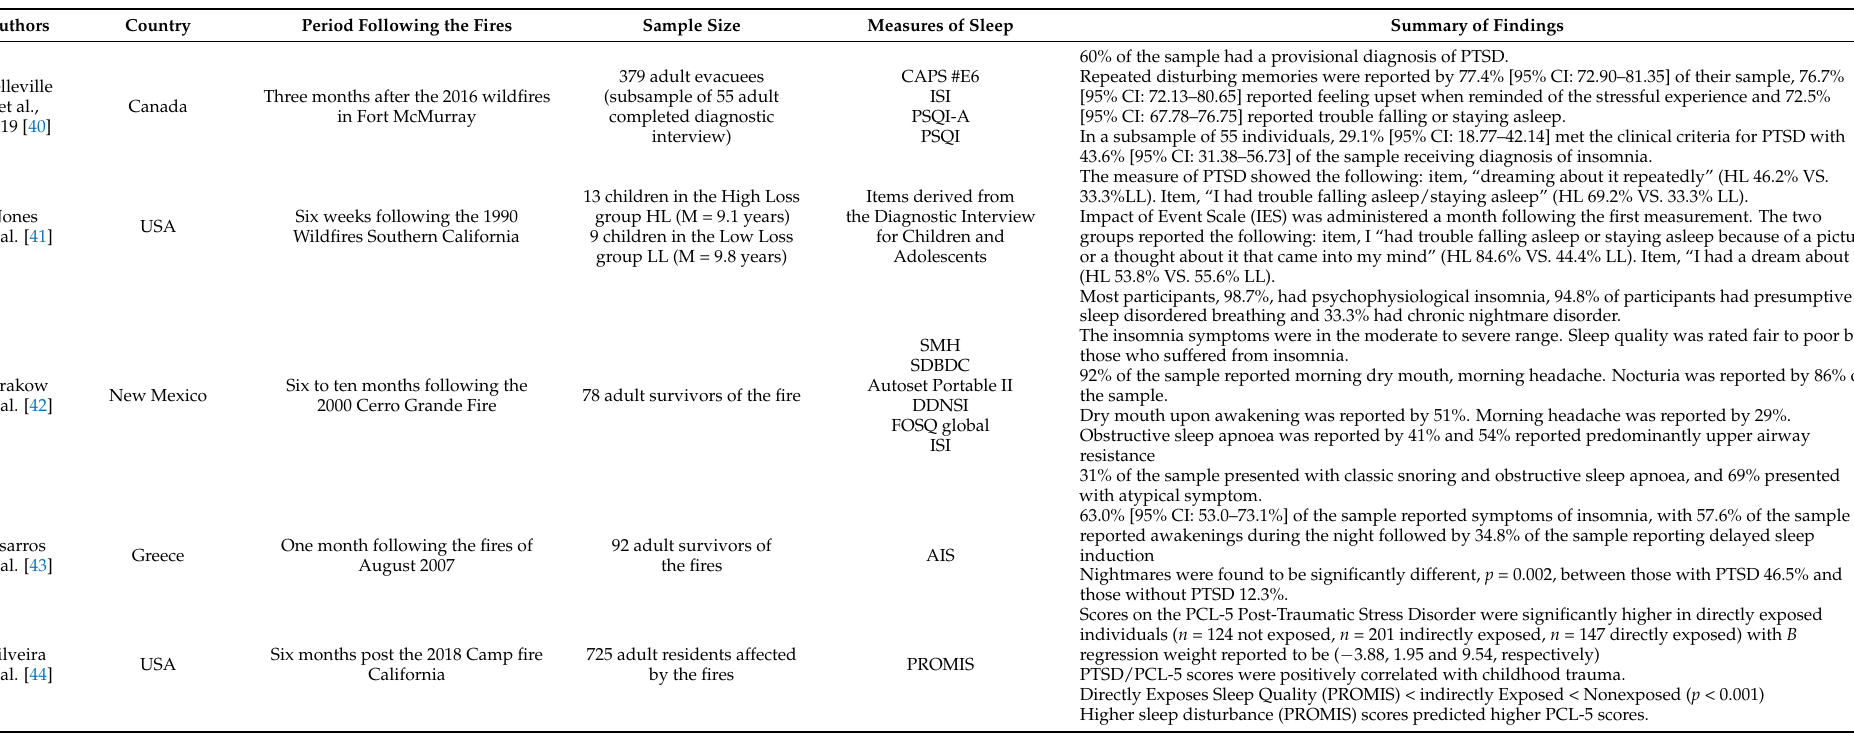
Table 2. Summary of studies published between 1990 and 2021 examining the impact of bushfires on sleep quality in bushfire